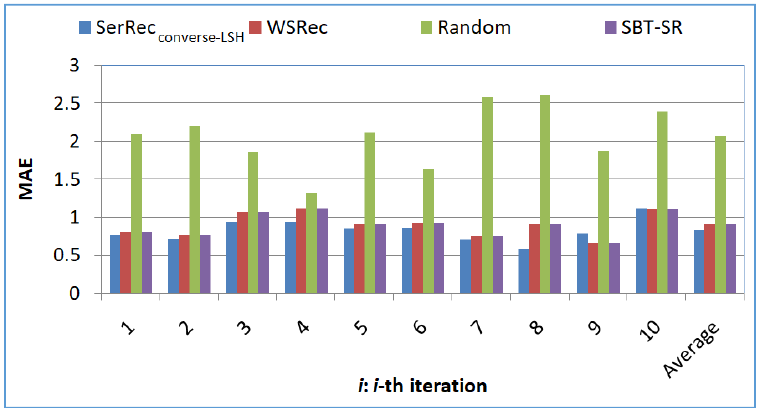
Figure 3. Accuracy of recommended results.